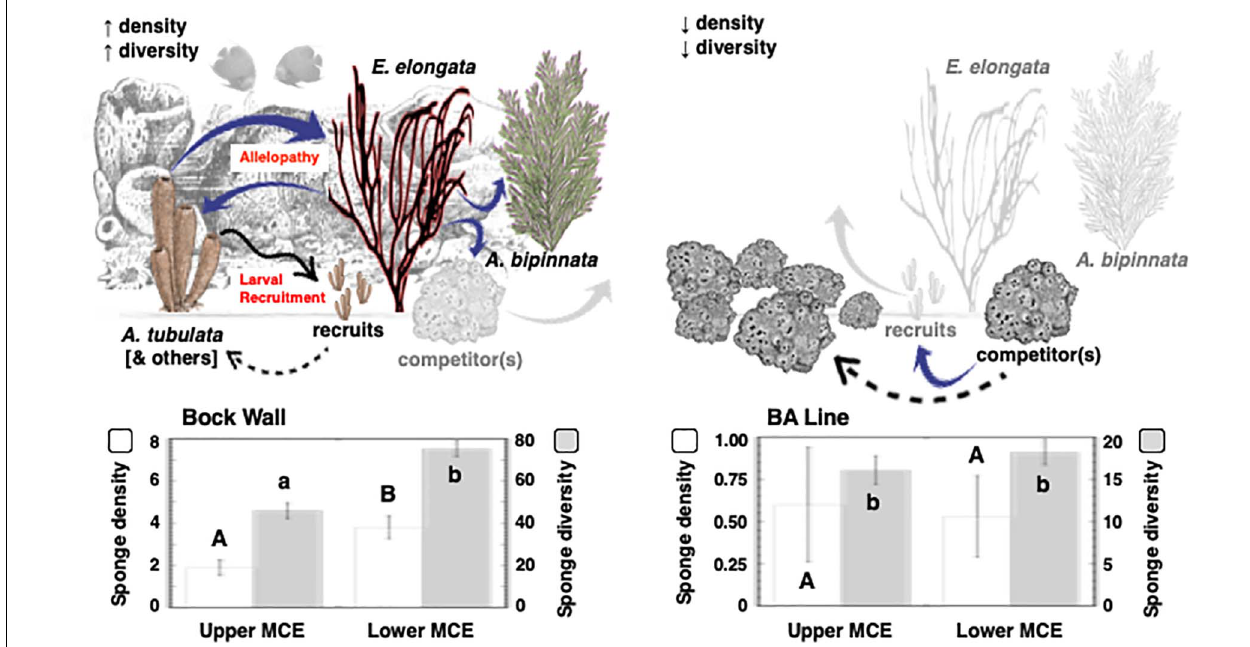
FIGURE 2 | Sponge density and diversity in the presence and absence of gorgonians. Histograms represent replicate ( n = 5–10) quadrats at random points along replicate 30 m transects ( n = 3–9) at depths of 46 and 76 m at two sites in the Bahamas (Bock Wall and BA Line). Conceptual model includes blue arrows indicating likely paths of allelopathic activity, and black arrows indicating recruitment. An unidentified sponge competitor is possibly excluded from communities with the gorgonians A. bipinnata and E. elongata (gray arrows) but excludes most species in the absence of these gorgonians.